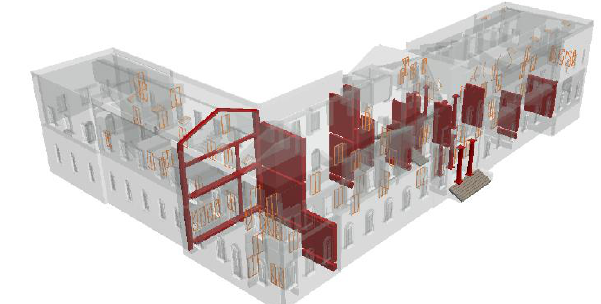
Figure 12 Structural intervention implemented in 2017, after Abruzzo earthquake. The elements that were affected by the last structural